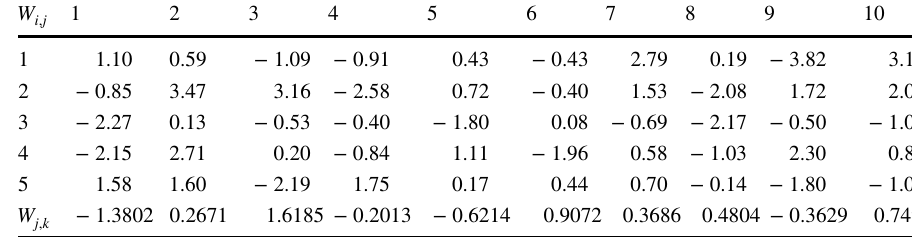
parameters for neural network correlations ( i = 5, j = 10, k = 1) for cyanide